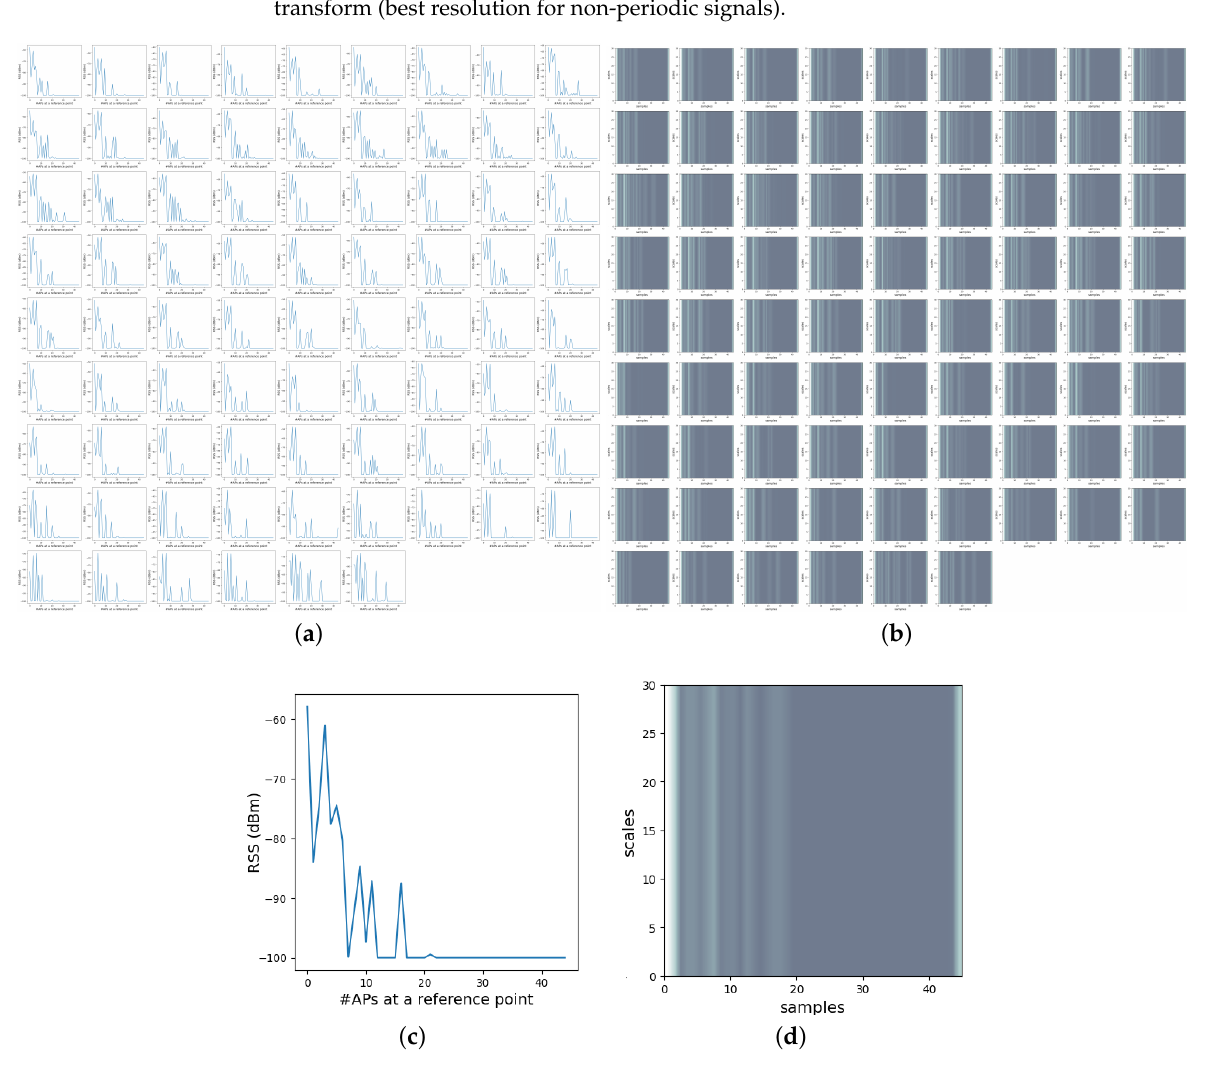
Figure 9. 1D RSS samples gathered from 45 APs and their corresponding 2D CWTs on 78 reference points. ( a ) 1D RSS samples gathered from 45 APs on 78 reference points. ( b ) corresponding 2D CWTs to 1D RSS samples on 78 reference points. ( c ) close-up view of RSS samples gathered at the first reference point. ( d ) close-up view of corresponding 2D CWTs to 1D RSS samples at the first reference